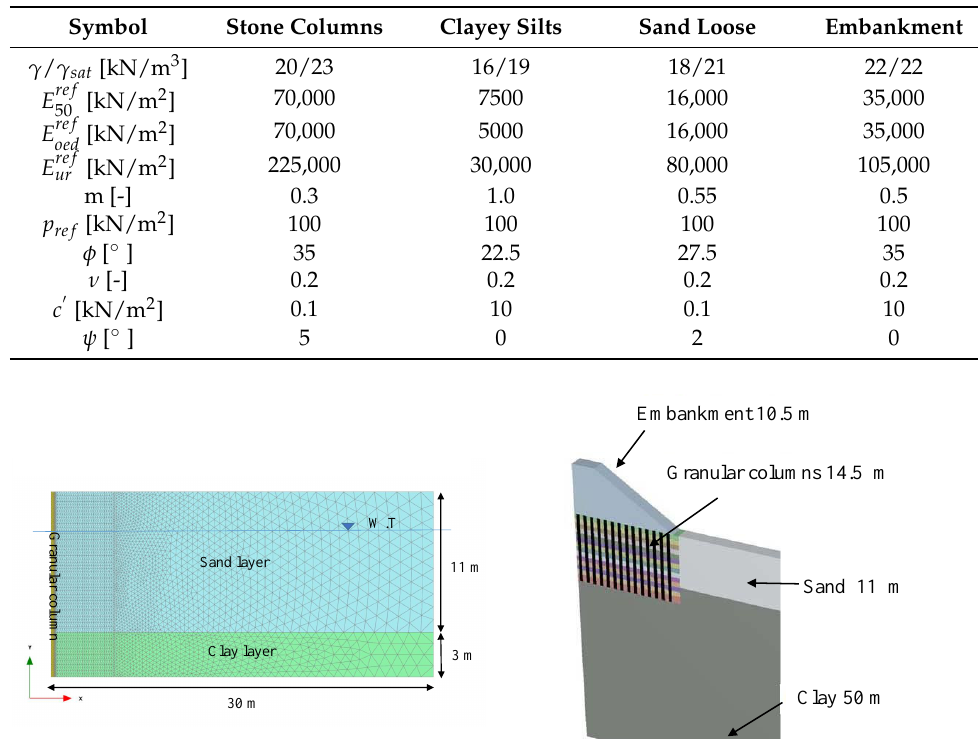
Table 1. Soil parameters adopted by [16].